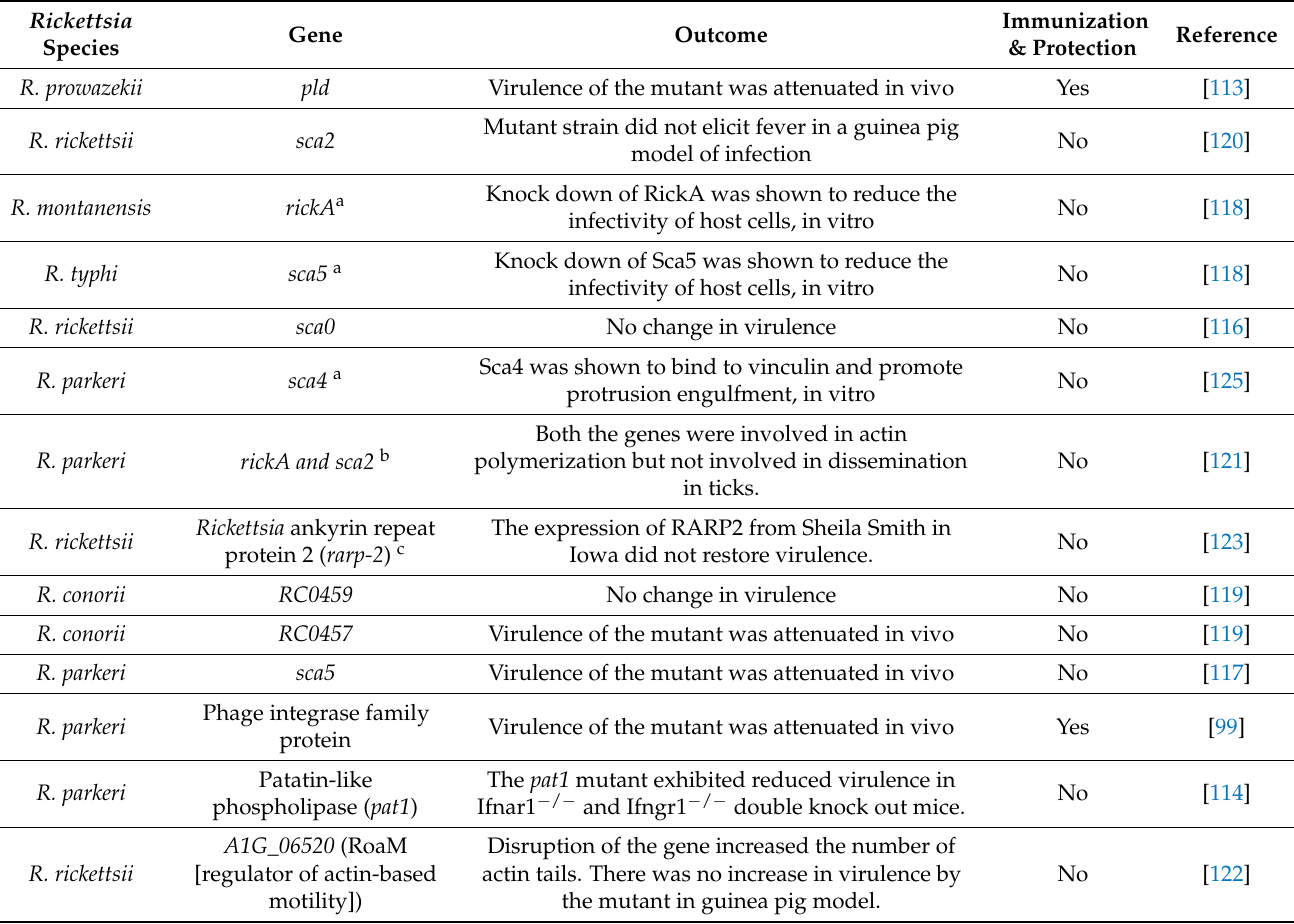
Table 1. List of rickettsial genes disrupted (knock-out or knock down) and tested for their role in virulence and immune